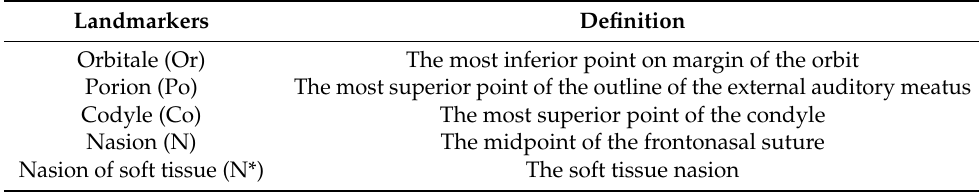
Figure 2. The 3D cephalometric measurements shown on virtual models: ( a ) craniomaxillofacial bone measurements; ( b ) facial soft-tissue measurements. Table 1. Definitions of the 3D cephalometric landmarks and measurements.